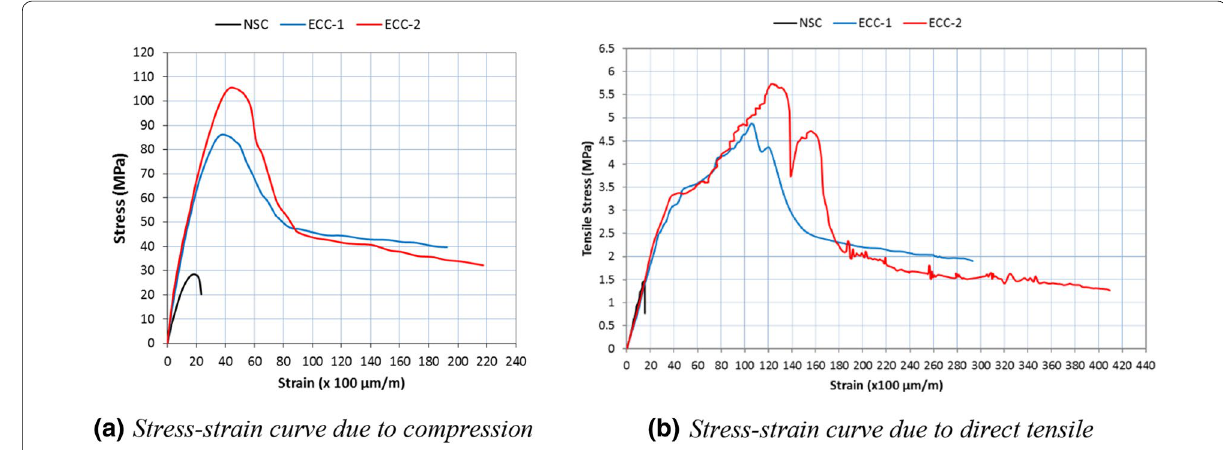
Fig. 5 Stress–strain relationship due to compression and direct tensile.